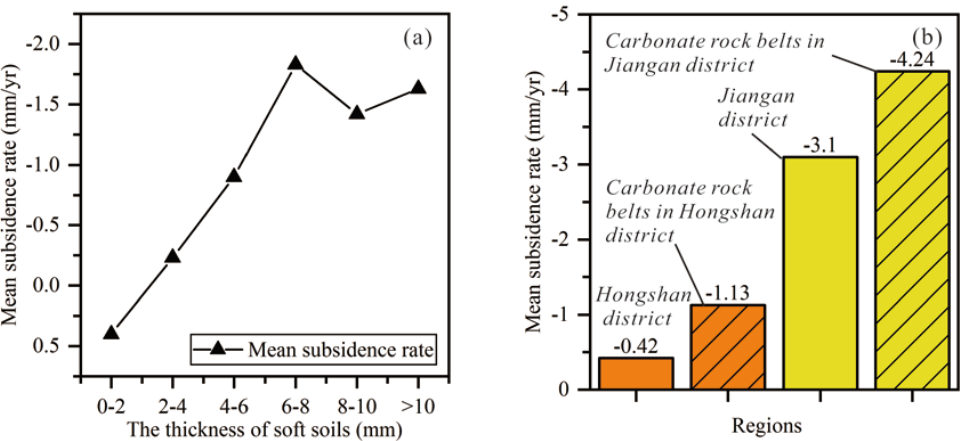
Figure 8. ( a ) Relationship between soft soil thickness and subsidence rate. ( b ) The subsidence rate of